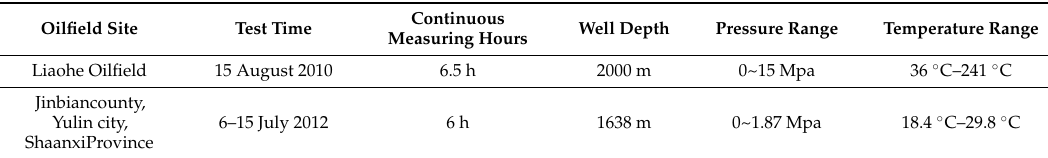
Table 5. Oilfield test details.